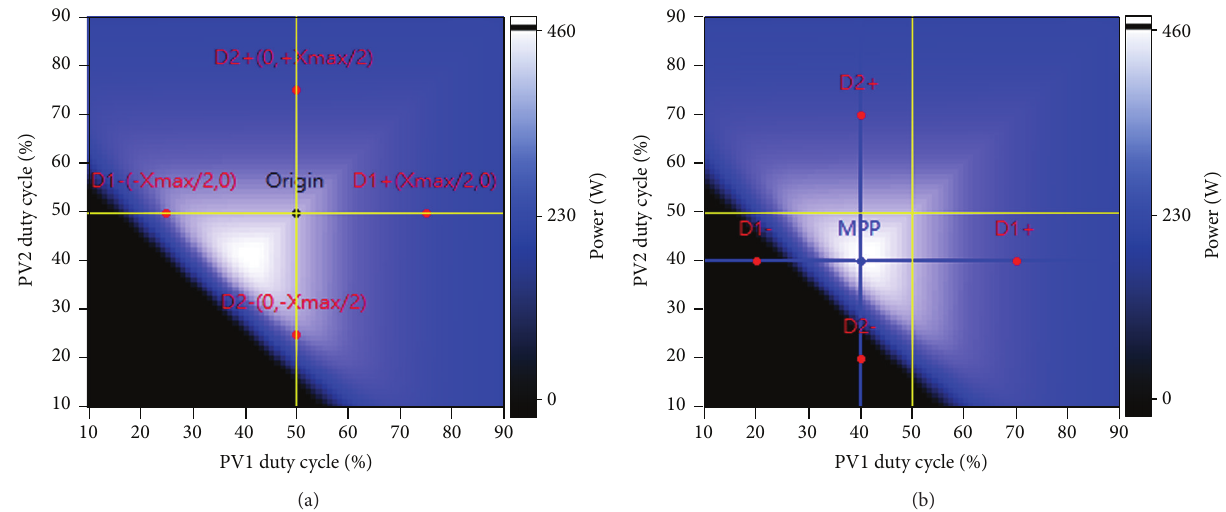
Figure 9: Agent deployment strategy: (a) Initial location is set to one-quarter or three-quarters of the entire adjustable range; (b) retracking location is calculated from current maximum power position to the searching boundary multiplied by the percentage change of the output power.